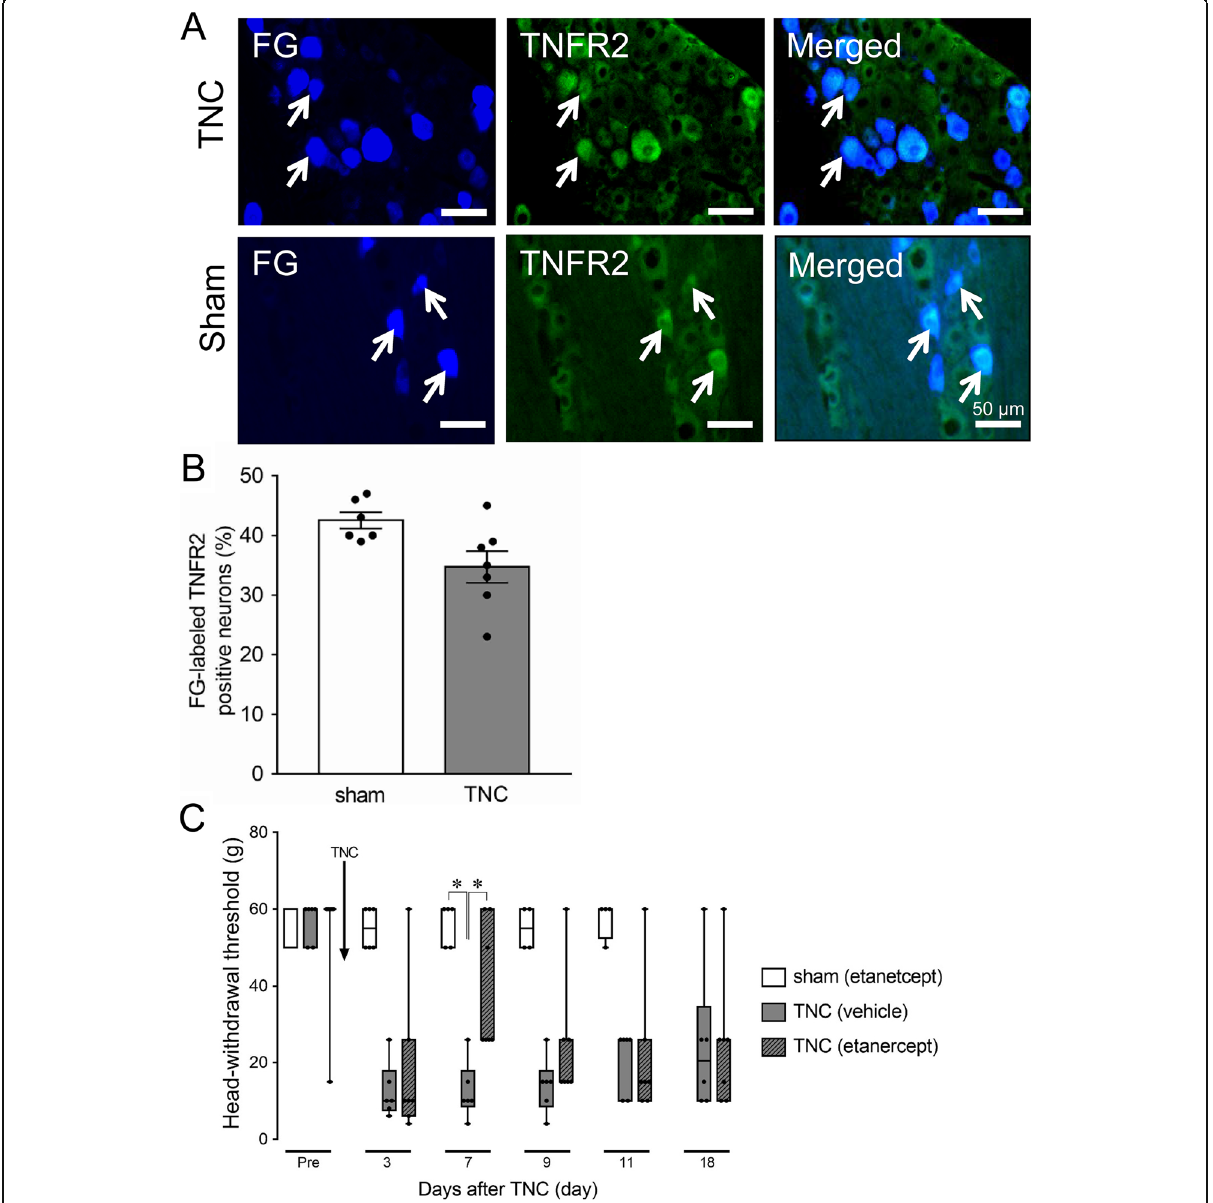
Fig. 3 TNFR2 expression in TG neurons innervating the whisker pad skin on day 7 following TNC or sham treatment. a Photomicrographs of FG- labeled TNFR2-IR cells in the TG on day 7 following TNC or sham treatment. Arrows indicate FG-labeled TNFR2-IR cells. Scale bar: 100 μ m. b Mean percentage of FG-labeled TNFR2-IR cells in the TG on day 7 following TNC or sham treatment. ( n =6 in each). c Effect of intra-TG etanercept or vehicle administration on day 4 on orofacial mechanical hypersensitivity following TNC or sham treatment. Data are presented as median, interquartile range (25 – 75%), and maximum and minimum values. * p <0.05. ( n =4 – 6; Kruskal-Wallis followed by Dunn ’ s multiple comparisons